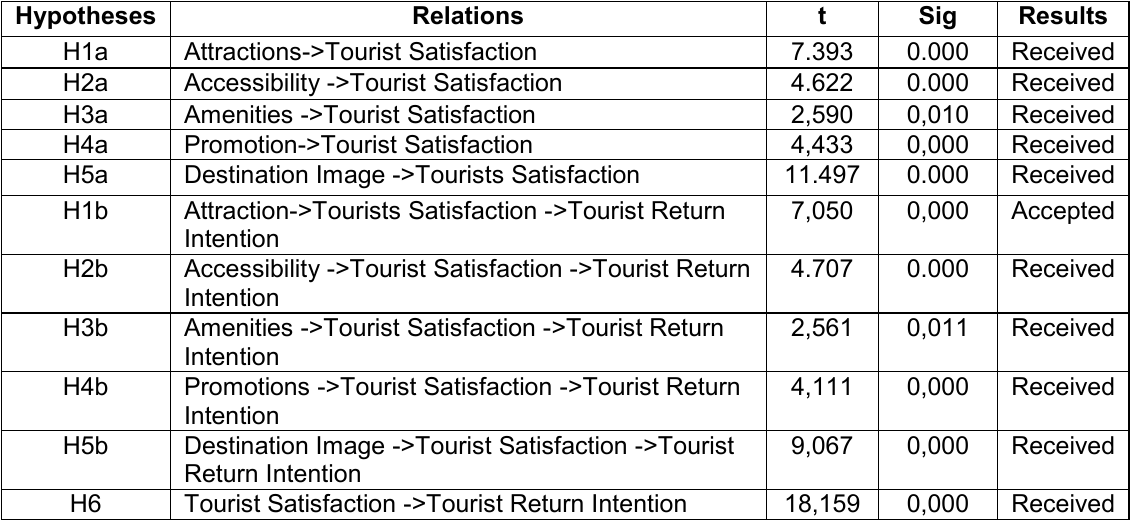
Table 5: Results of